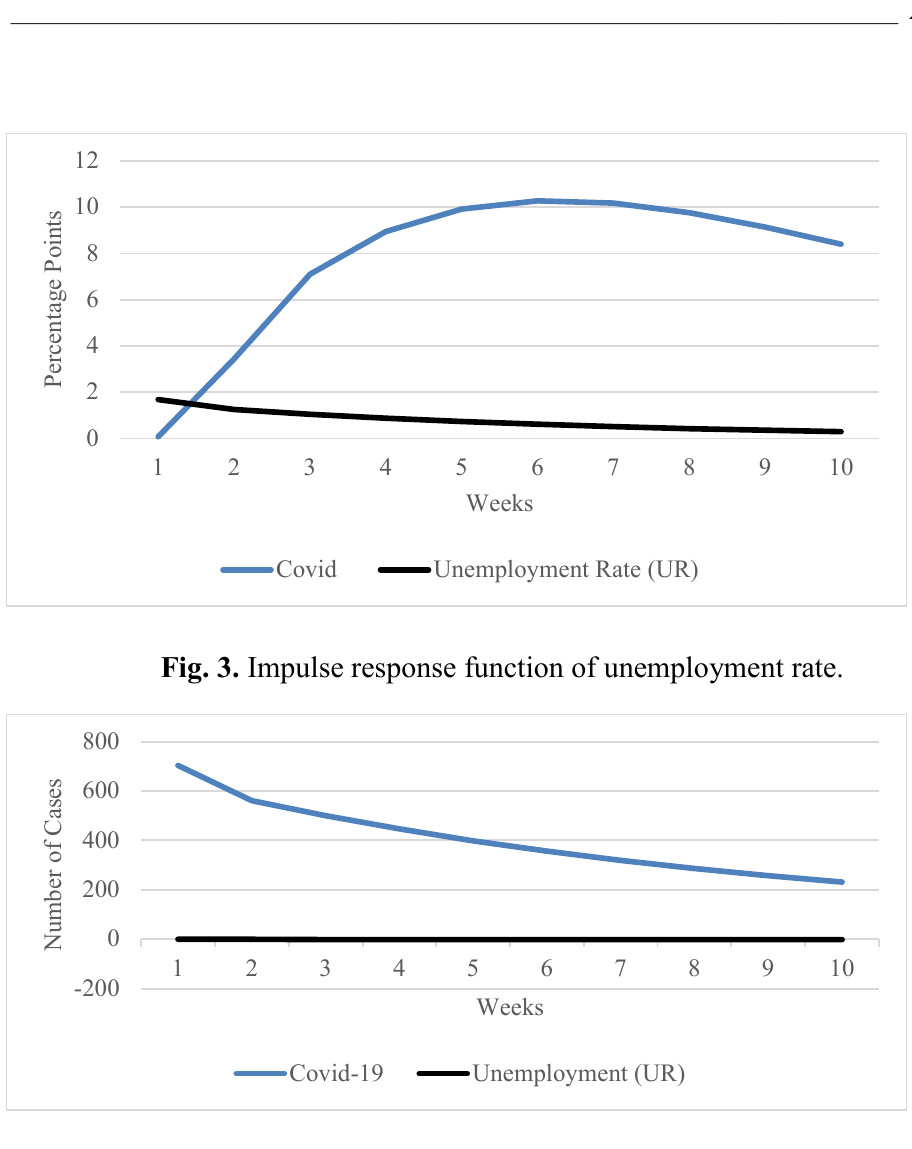
Fig. 4. Impulse response function of Covid-19 contagion